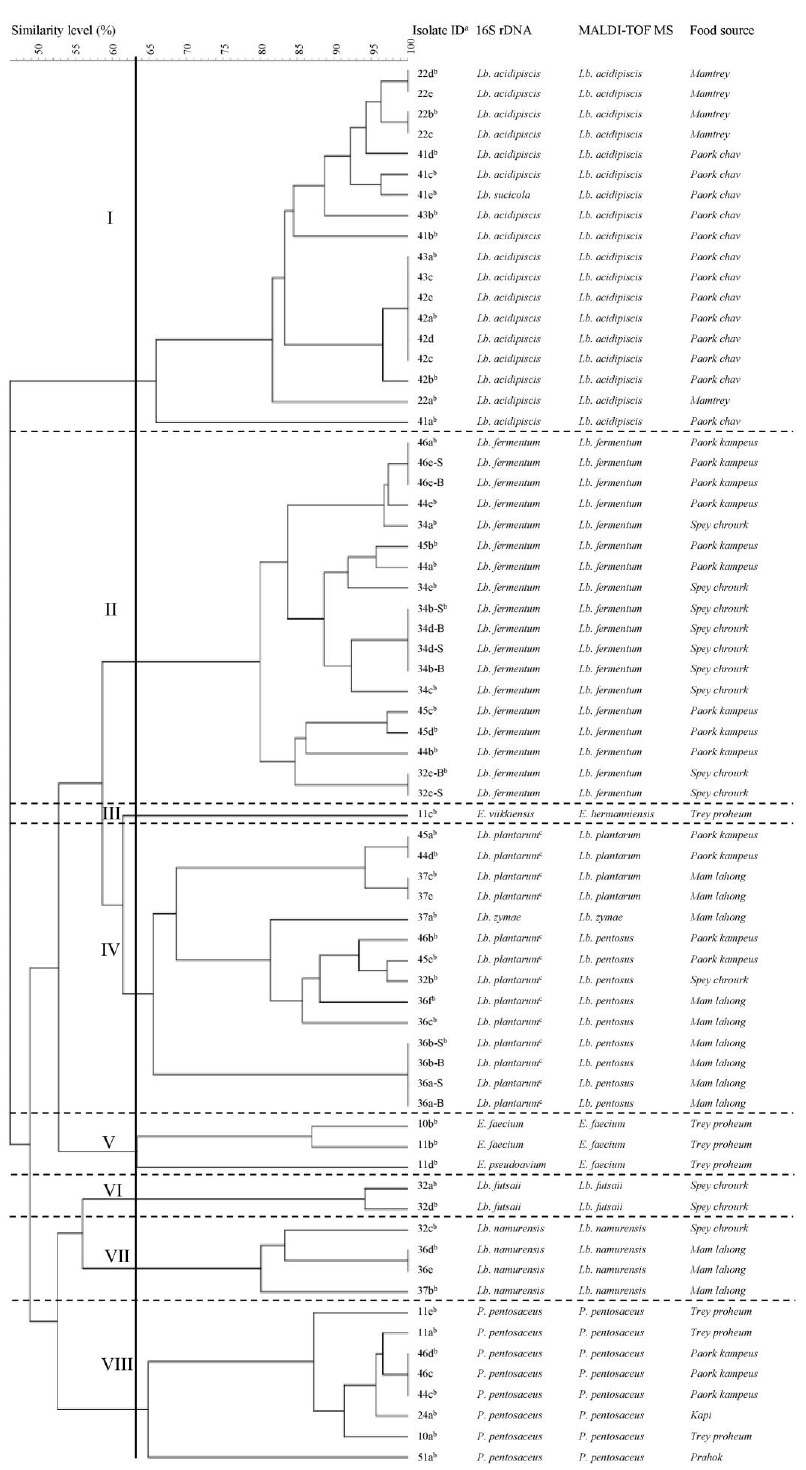
Figure 1. Dendrogram based on cluster analysis of rep-PCR (GTG) 5 fingerprints obtained for LAB isolatedfromCambodianfermentedfoodsandidentifiedatspecieslevelbypartial16SrDNAsequencing and MALDI-TOF MS (Bruker Biotyper). The dendrogram was constructed by the unweighted pair group method using arithmetic (UPGMA) mean with similarity levels expressed as percentage values of the Dice correlation coe ffi cient. All isolates with a similarity of 100% and the same source were regarded as multiple isolates representing a single strain. a Identity. b Single strain used for GABA screening by TLC. c Lb. plantarum / Lb. paraplantarum / Lb. pentosus cannot be distinguished by partial 16S rDNA